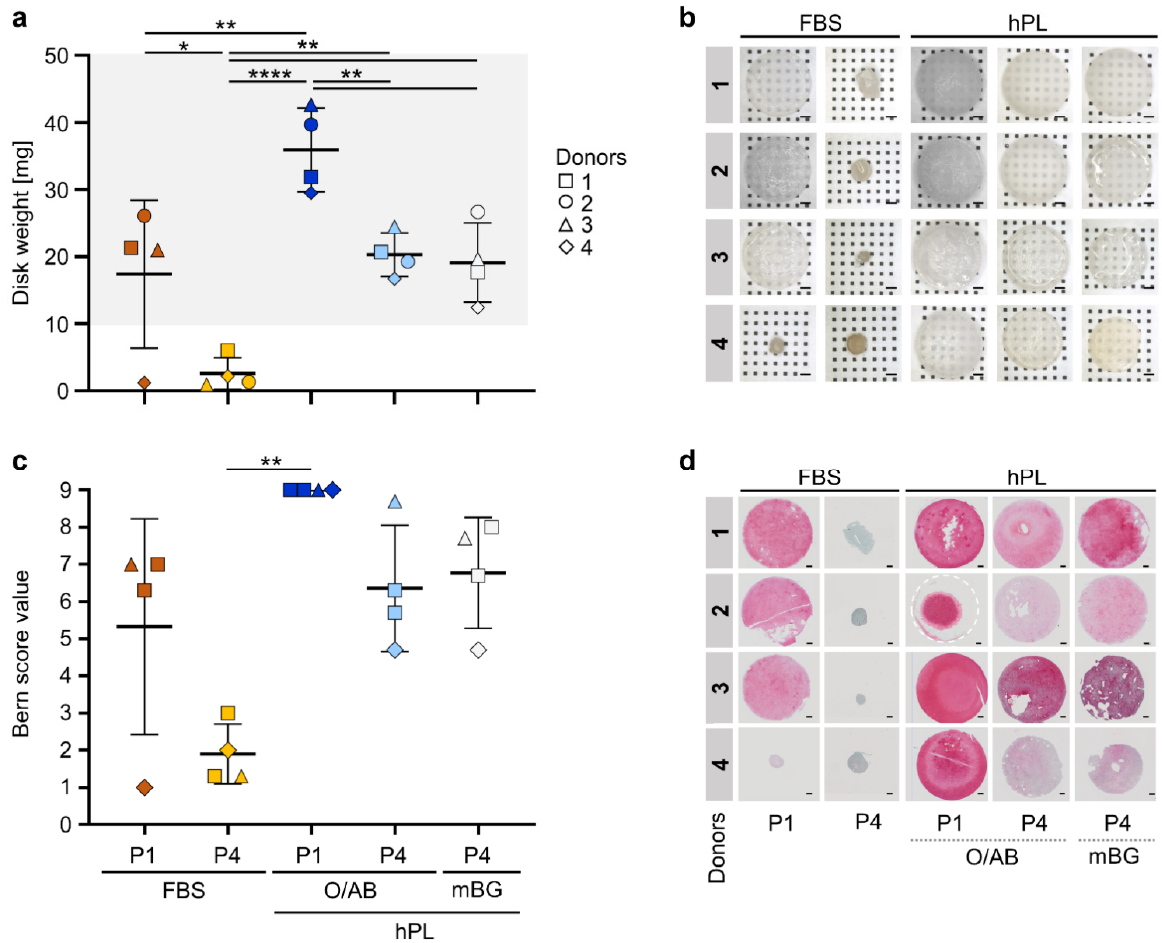
Figure 5. Organoid-like 3D cartilage disk formation. ( a ) Weight of 3D cartilage disks generated in triplicates from BMSCs of four donors (1–4, depicted with symbols as indicated), pre-expanded in different media, and differentiated after P1 or P4 as indicated. One to three representative disks per sample were fixated and weighed and the remaining two discs were snap frozen for further analysis. Proper disk formation resulted in disks > 10 mg (grey area). Repeated measures, one-way ANOVA with multiple comparisons (Tukey), p -values of multiple comparisons as depicted (* p < 0.5, ** p < 0.01, **** p < 0.0001). ( b ) Representative pictures of corresponding fixated 3D cartilage disks created from BMSCs of donors 1–4 after hPL- or FBS-expanded early (P1) and late passage (P4) cultures as indicated. Scale bar 1 mm; n = 4. ( c ) Bern scoring of stained cartilage disk sections by three individual experts in blinded fashion; mean ± SD results, statistics as in ( a ), n = 4. ( d ) Representative corresponding Safranin O/Fast Green staining results depicted as indicated. Entire disk sections shown except for donor 2 hPL O/AB where curved structure disabled perfect sectioning and disk margin was illustrated by a white hatched line. Scale bar 1 mm.